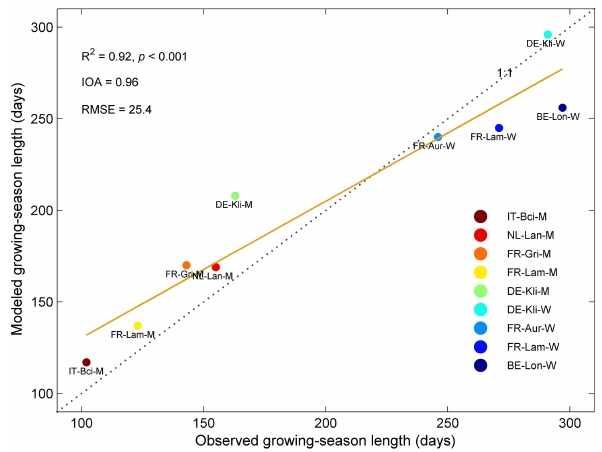
Figure 3. Comparisons of the observed and modeled (ORC-CP1; in detail see Table 3) growing-season lengths (from sowing to matu- rity) for winter wheat and maize in different sites. Different colors indicate data for different